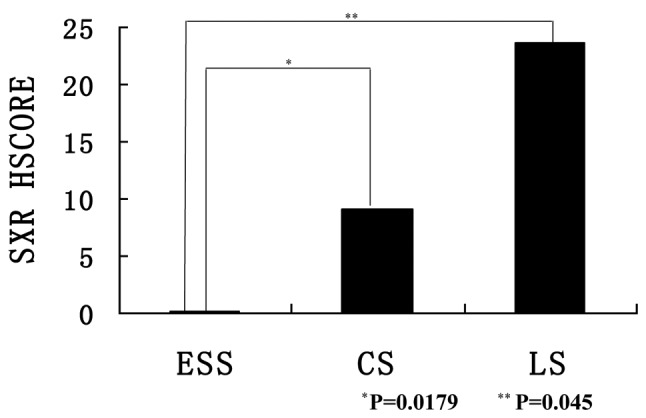
Comparison of steroid and xenobiotic receptor (SXR) HSCORE among uterine sarcomas. All cases were scored by a semi-quantitative histological scoring (HSCORE) method. Student’s t-test was used to analyze the association of SXR HSCORE. Results are expressed as the mean ± standard error (SE). *P=0.0179 vs. carcinosarcoma (CS); **P=0.045 vs. leiomyosarcoma (LS). ESS, endometrial stromal sarcoma.